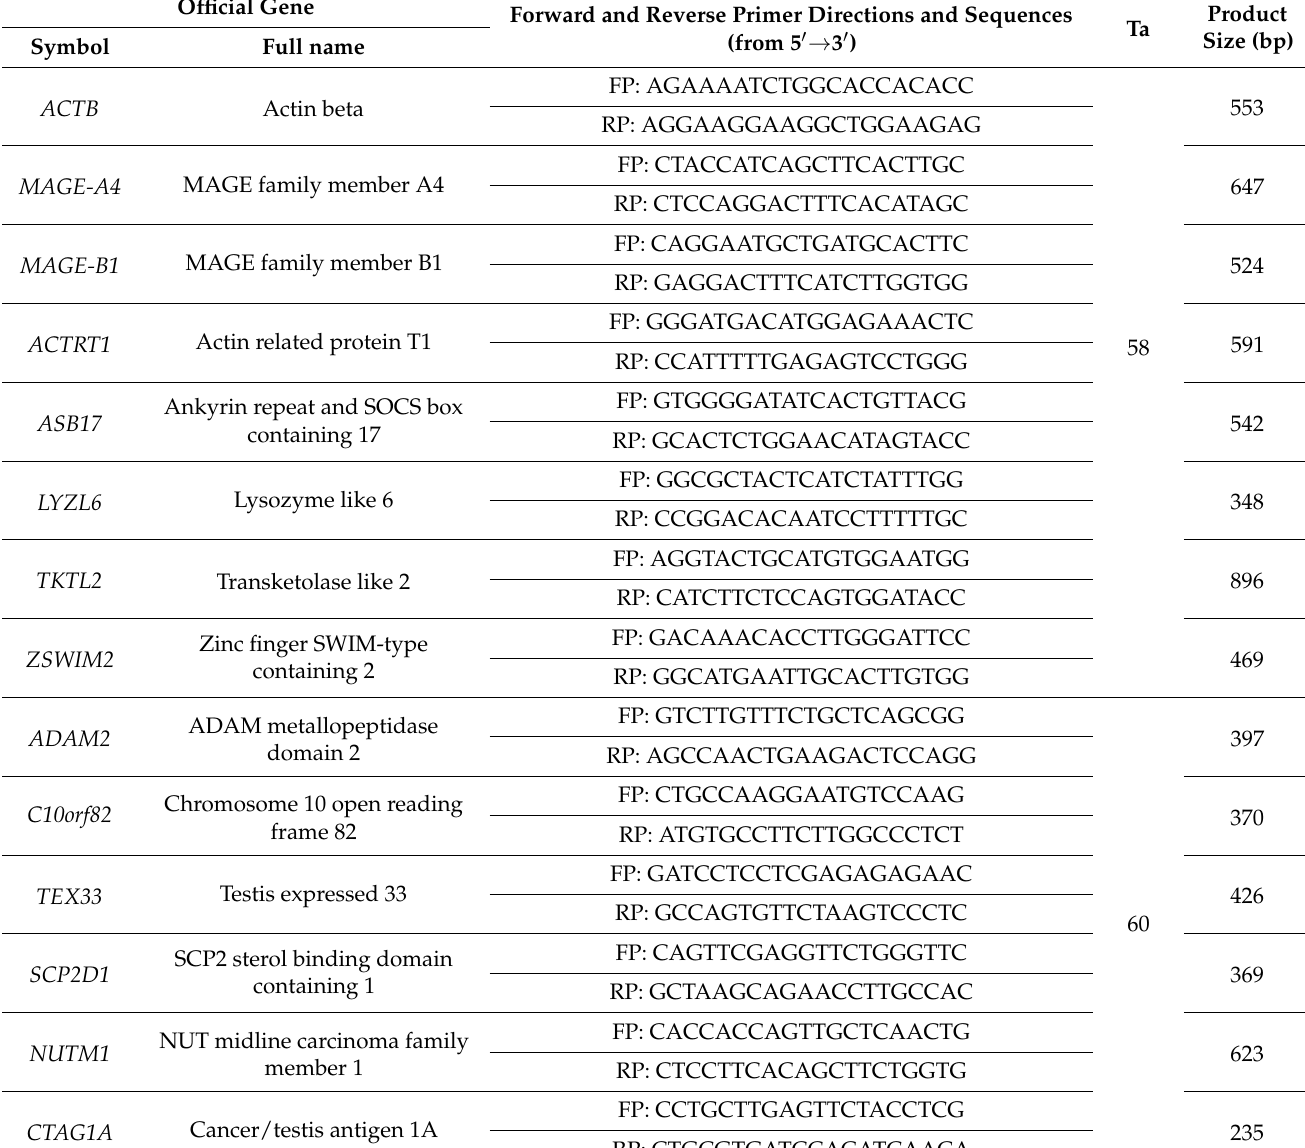
Table 1. Sequences of the primers used in the RT-PCR and their estimated product